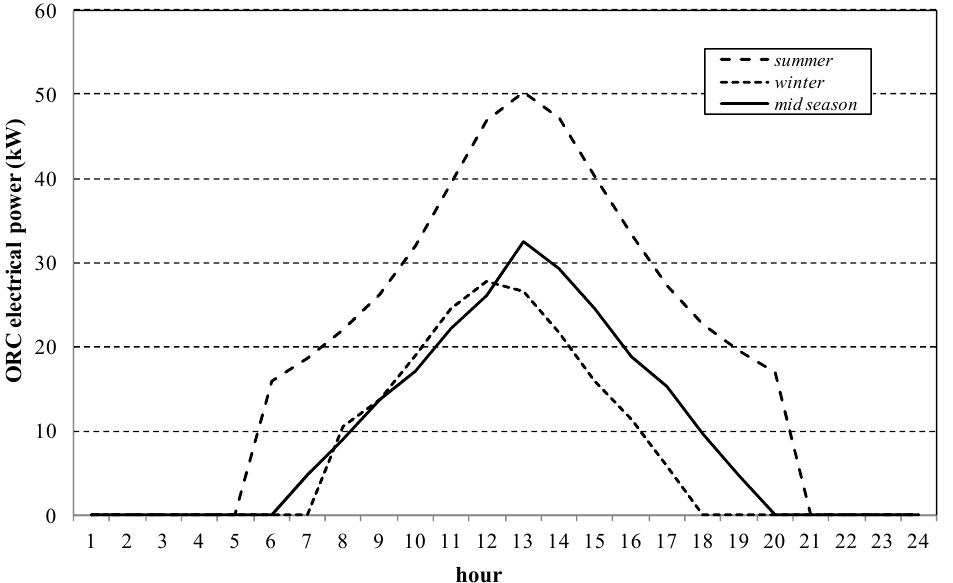
Figure 8. Electrical production of the ORC system in the summer, winter, and middle seasons.